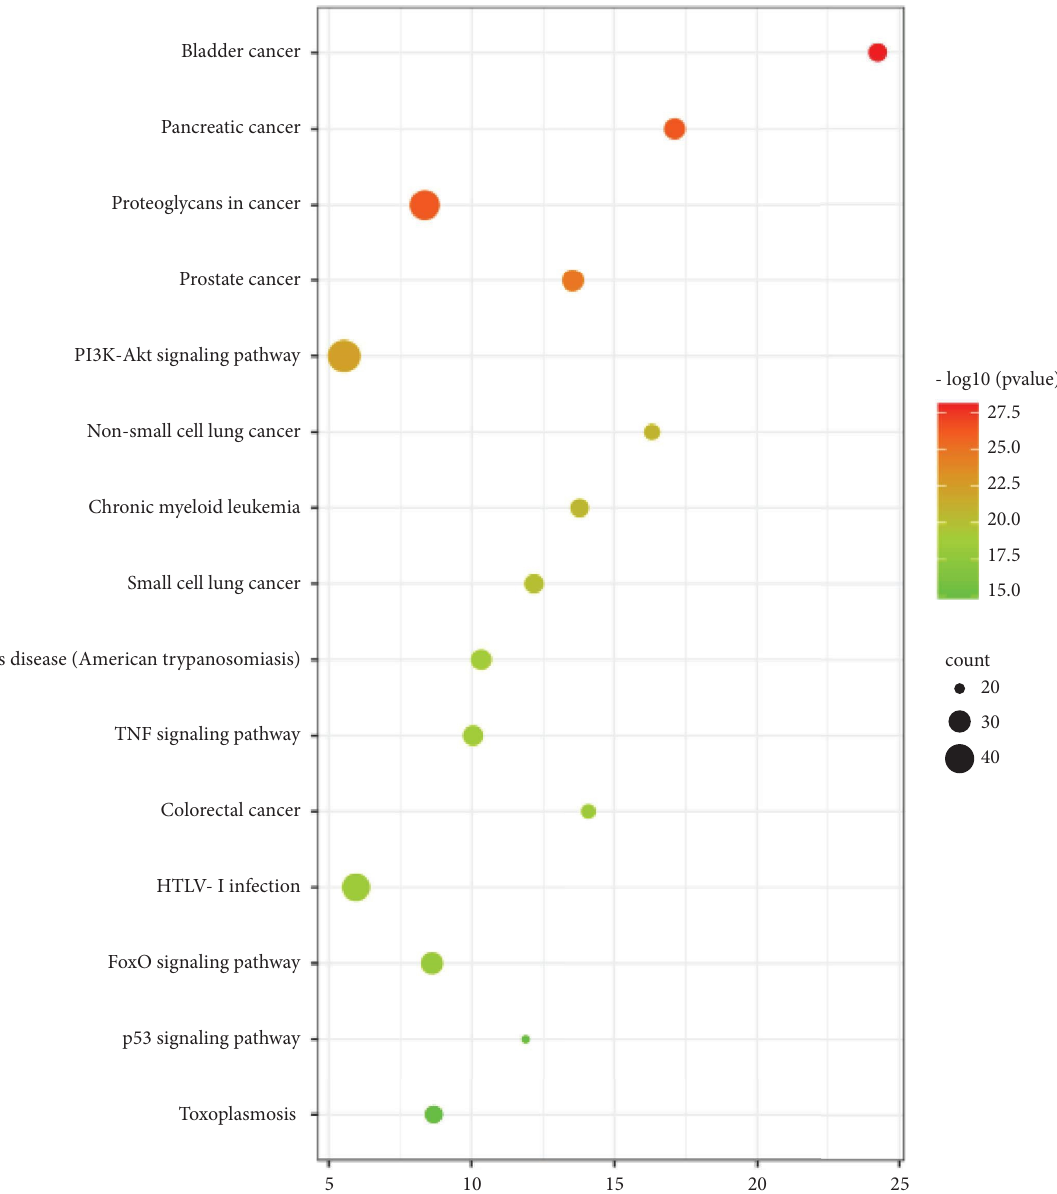
Figure 6: KEGG pathway enrichment analysis of putative target genes. Tere were twelve KEGG pathways with a signifcant P value < 0.001. Te targets of SLC had direct or indirect correlation with the KEGG pathways which correlated well with cancer. Tus, the ingredients of SLC could regulate these pathways such as TNF signaling pathway and PI3K-Akt signaling pathway to